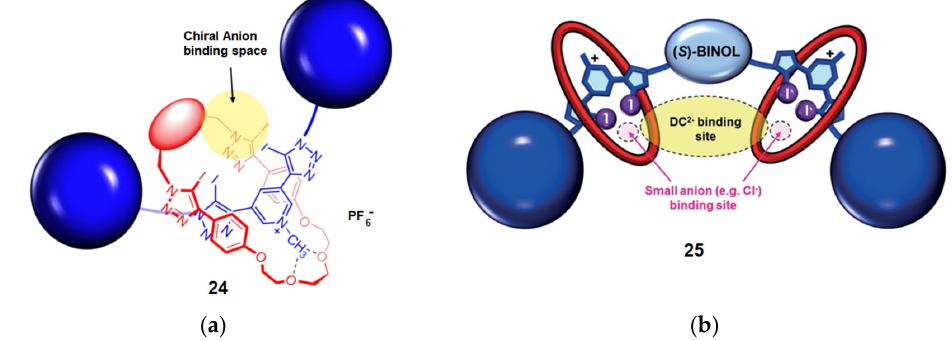
Figure 14. Design of XB-based [2]-rotaxane 24 ( a ) and [3]-rotaxane 25 ( b ) for chiral recognition of anions (Reprinted/adapted with permission from Ref [92]. Copyright 2017, American Chemical Society and from Ref [93]. Copyright 2018, Wiley).